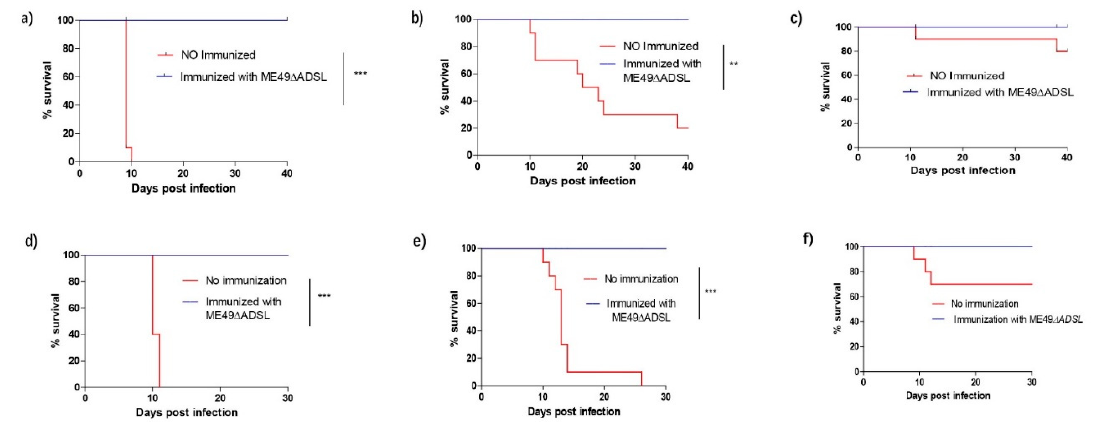
Figure 3. Δ ADSL parasite immunization protected mice from Toxoplasma gondii tachyzoite infection. ICR mice were pre-immunized with 100 tachyzoites of the ME49 Δ ADSL mutant. ( a – c ) Thirty days post-immunization, the immunized mice were challenged with 500 RH tachyzoites ( a ), 10 3 ME49 tachyzoites ( b ) or 10 3 VEG tachyzoites (( c ); 10 mice for each strain) by intraperitoneal injection, and their survival was monitored for another 40 days. ( d – f ) 75 days post-immunization, 500 tachyzoites of the RH Δ hxgprt ( d ), ME49 ( e ) or VEG ( f ) strains were used to challenge the mice, and mouse survival was monitored for another 30 days. Non-immunized mice were included as controls. ** p <